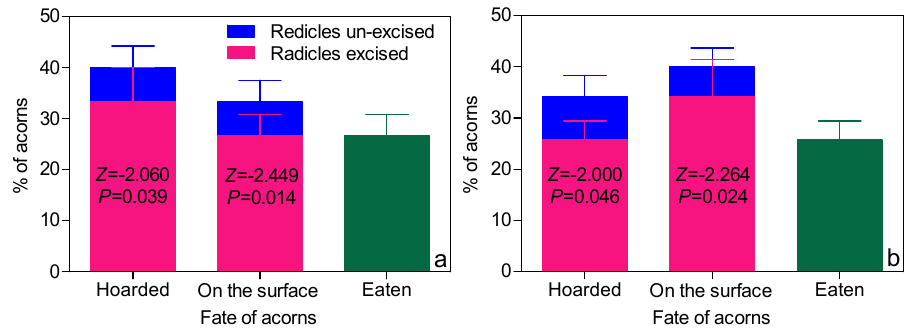
Figure 2. The processing and hoarding of rodents on germinated acorns in ULRS ( a ) and LRS ( b ). The proportion of radicle-excised acorns (pink bar) and radicle un-excised acorns (blue bar) was compared in Two-Related Samples Wilcoxon Tests.